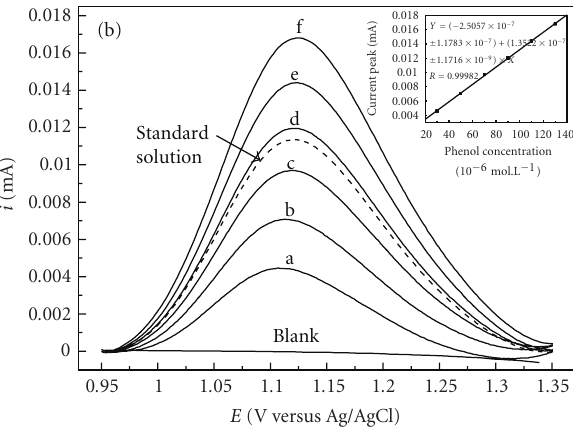
Figure 13: Square wave voltammogram in 0.5molL − 1 H 2 SO 4 for di ff erent phenol concentrations from (a) 30; (b) 50; (c) 70; (dash style) standard solution; (d) 90; (e) 110 and (f) 130 μ molL − 1 , using BDND electrode. f = 60Hz, step potential = 2mV and amplitude = 70mV. Inset: analytical curve for phenol